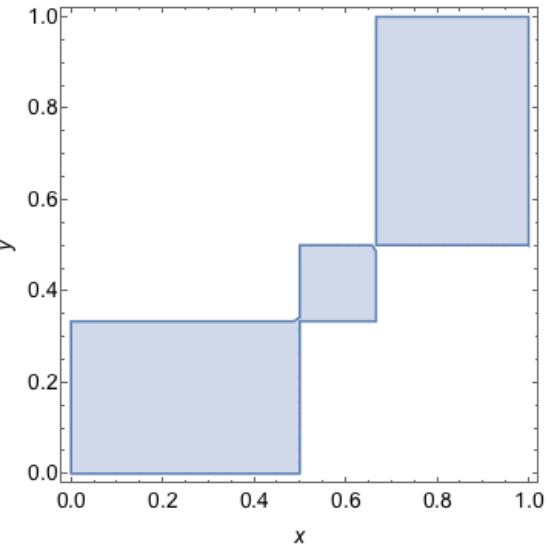
Figure 9. Set of QRE-achievable states for a coordination game with a Y < b Y . A point ( x , y ) represents a mixed strategy profile where the first agent chooses its first strategy with probability x and the second agent chooses its first strategy with probability y . The grey areas depict the set of mixed strategy profiles ( x , y ) that can be reproduced as QRE states a coordination game with a Y < b Y , i.e., these are outcomes for which there exists temperature parameters ( T x , T y ) for which the ( x , y ) mixed strategy profile is a